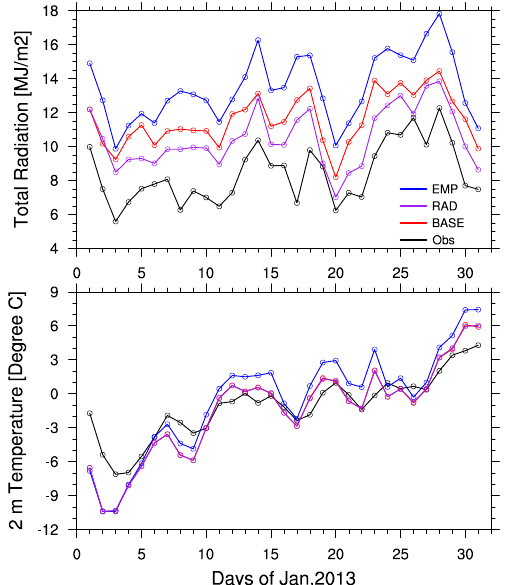
Figure 13. Observed (black) and simulated (red for the BASE sce- nario and blue for the EMP scenario) monthly mean PM 2 . 5 mass concentrations in January 2013 over the NCP, YRD, PRD and CC. The dashed lines indicate the maximum and minimum values. The solid lines in the box indicate the median value (the central line), the 25th and 75th percentiles.